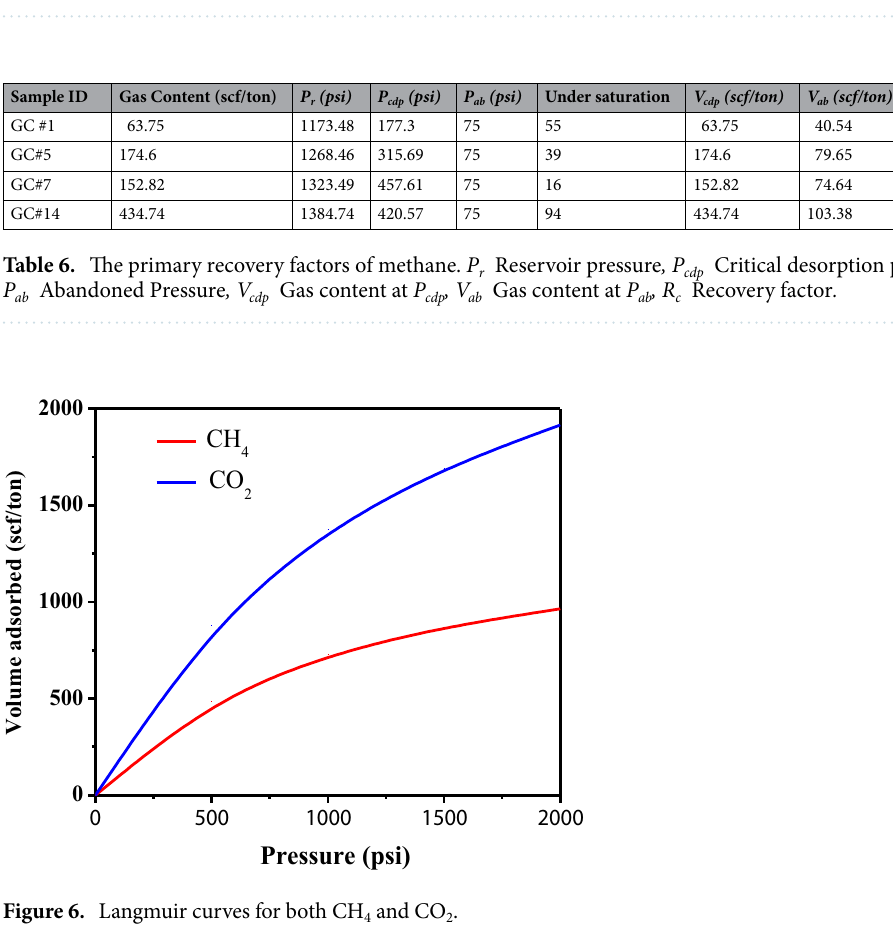
Table 5. Langmuir constants of the coal samples. Tr Reservoir temperature.